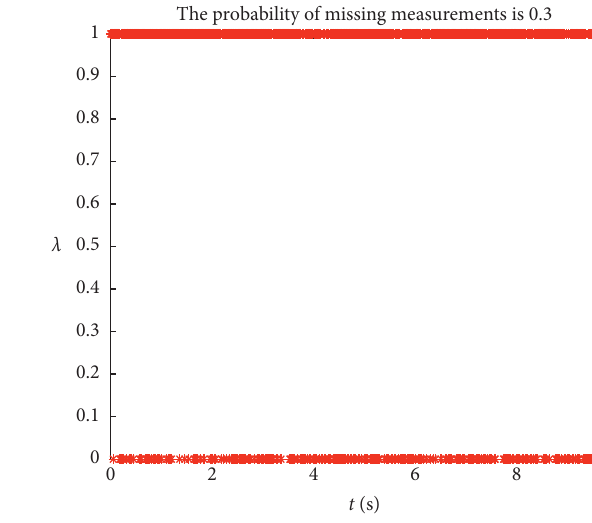
Figure 2: The missing measurements in feedback channel.